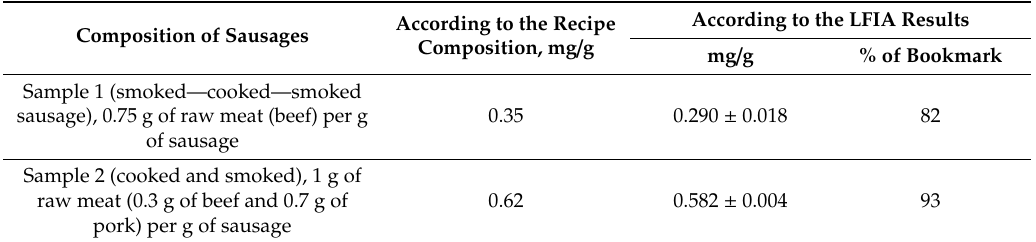
Table 2. Amounts of TnI, calculated from the added raw materials and from the LFIA data. According to the LFIA According to the Recipe Composition of Sausages Composition, mg / g